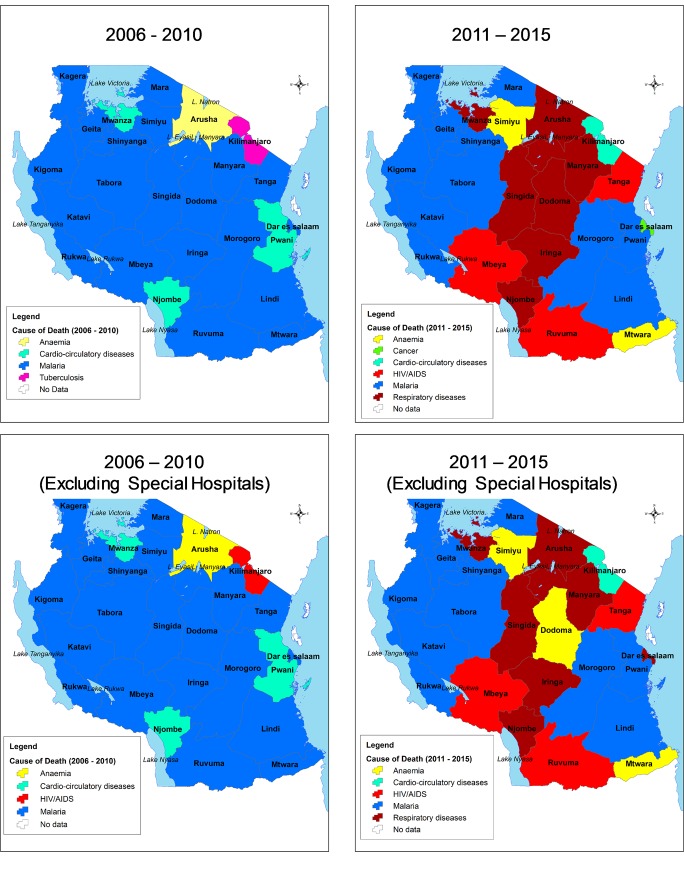
Leading causes of death in regions comparing periods of 2006–2010 and 2011–2015.Maps are shown with inclusion or exclusion of special hospitals.